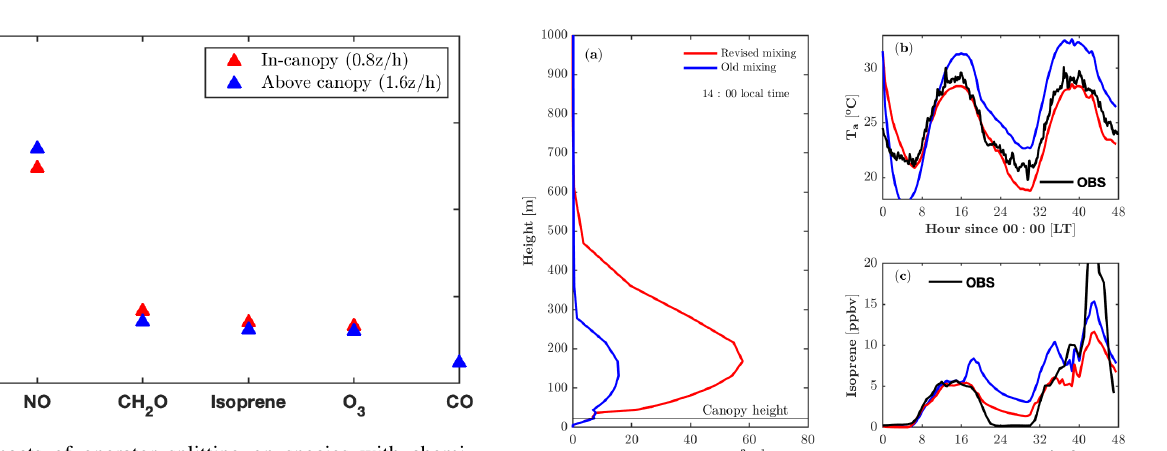
Figure 2. Impacts of operator splitting on species with chemi- cal lifetimes ranging from seconds (OH; Di Carlo et al., 2004) Figure 3. Impacts of the revised mixing parameterization on air to months (CO; Holloway et al., 2000). The relative differences − C old temperature and isoprene. (a) Modeled vertical profile of the eddy ) for daytime between the two orders of operator (i.e., C new C old diffusivity at 14:00 local time on 22 July 2016. (b) Modeled and (10:00–16:00 local time) average hydroxyl radicals (OH), nitric ox- observed air temperature ( T a ) at 46m. (c) Modeled and observed ide (NO), formaldehyde (CH 2 O), isoprene, ozone (O 3 ), and carbon isoprene at monoxide (CO) at two heights (0.8 and 1.6 z/h ).